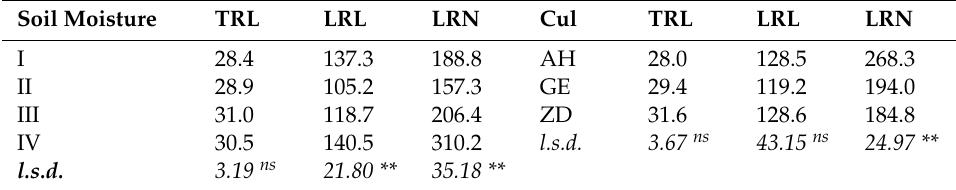
Table 7. Tap root length (TRL; cm), lateral root length (LRL; cm) and lateral root number (LRN) under various soil moisture (See Table 1 for soil moisture abbreviations) and cultivar (AH, GE and ZD) treatments. ** p < 0.01; ns-no